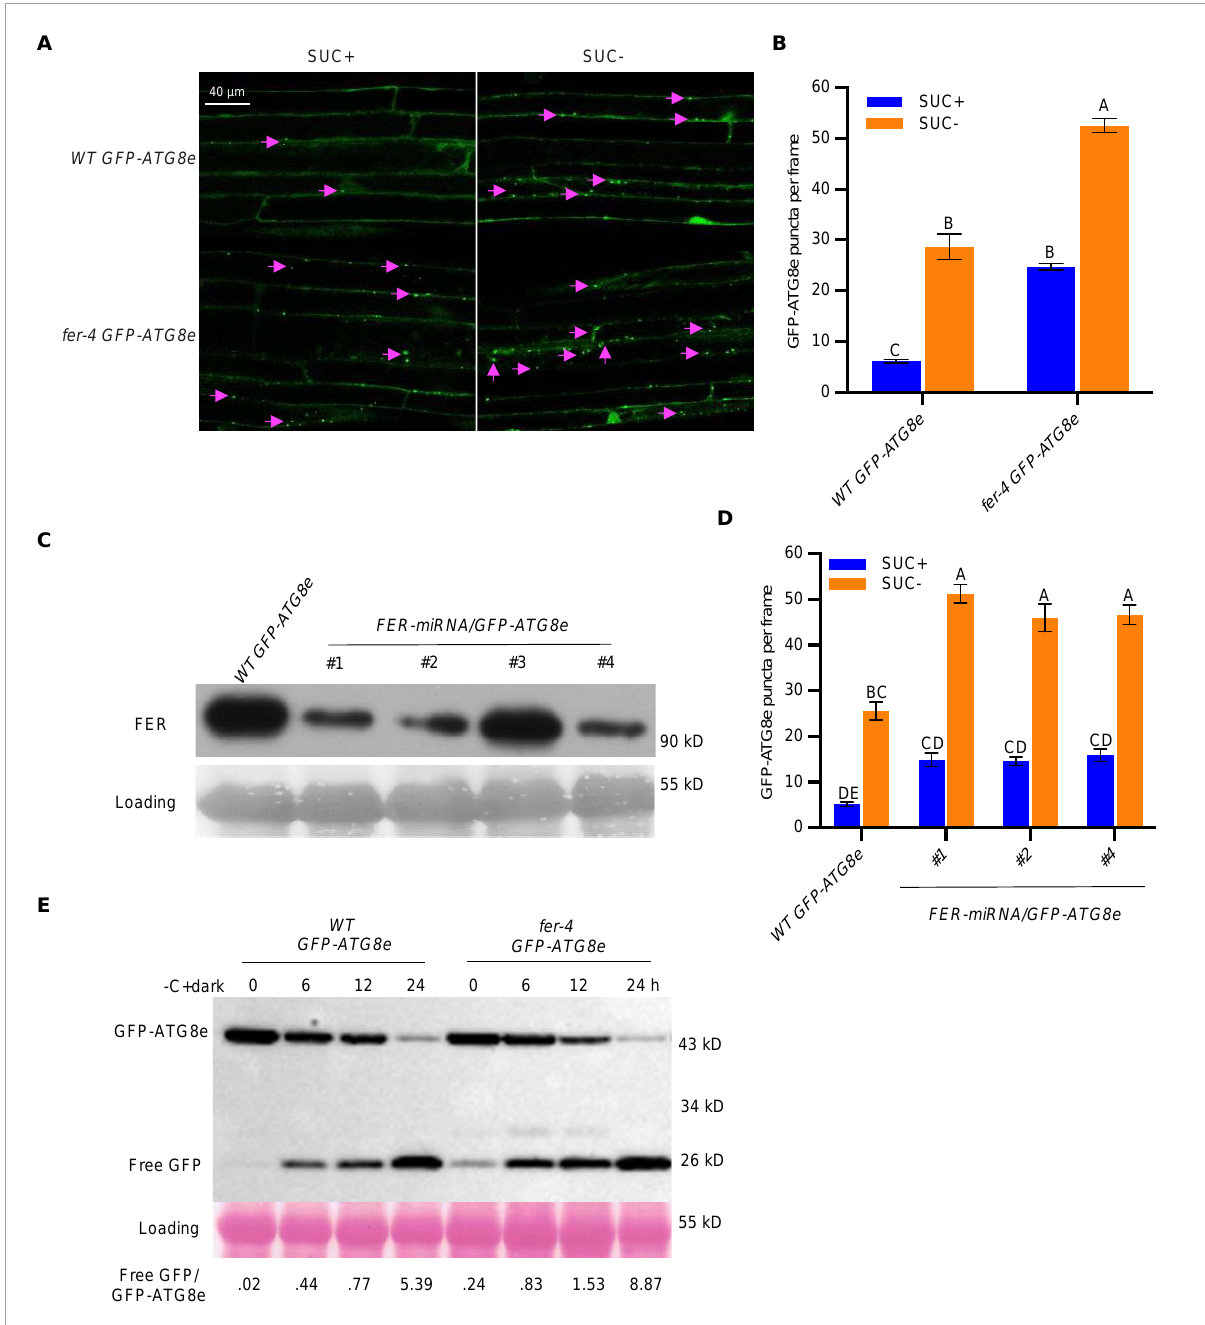
FIGURE2 FER negatively regulates autophagy under sucrose starvation. (A) Representative confocal microscopic images of WT and fer-4 with autophagosome marker GFP-ATG8e, under control (SUC +) and sucrose starvation (SUC-) conditions. The Lavender arrows indicate autophagosomes. Scale = 40 µ m. (B) Quantification of autophagosomes of the 10-day-old seedlings from (A) . Data are shown as means ± SEM from 3 biological replicates, with 6-12 images per replicate. Different letters indicate significant difference among groups subjected to one-way ANOVA Tukey’s multiple range tests ( p < 0.05). (C) Western blot showing the decreased FER protein levels in multiple T2 lines of FER-miRNA/GFP-ATG8e using anti-FER antibody (Guo et al., 2018). Lines #1, #2 and #4 were used for further autophagy analysis. Rubisco was used as loading control. (D) Quantification of autophagosomes of the 10-day-old seedlings from C with or without sucrose and grown in dark for 3 days. Data are shown as means ± SEM from 5-12 seedlings, with 2-3 images per seedlings. Different letters indicate significant difference among groups subjected to one-way ANOVA Tukey’s multiple range tests ( p < 0.05). (E) GFP-ATG8e cleavage assays showing the increased autophagic flux in fer-4 mutant. Seven-day-old WT GFP-ATG8e and fer-4 GFP-ATG8e seedlings were subjected to 1/2 LS liquid medium without sucrose for 6, 12, and 24 hours in dark. The total proteins were extracted and separated by SDS-PAGE gels followed by immunoblotting with anti-GFP antibody. Ponceau S staining serves as protein loading control. The values below the blots are the ratios of free GFP over GFP-ATG8e. This experiment was carried out two times with similar